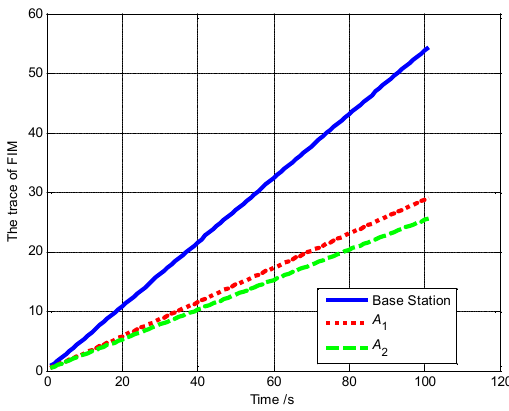
Figure 21. The trace of the FIM for A 1 , A 2 and base station (Group A in Scenario 2).